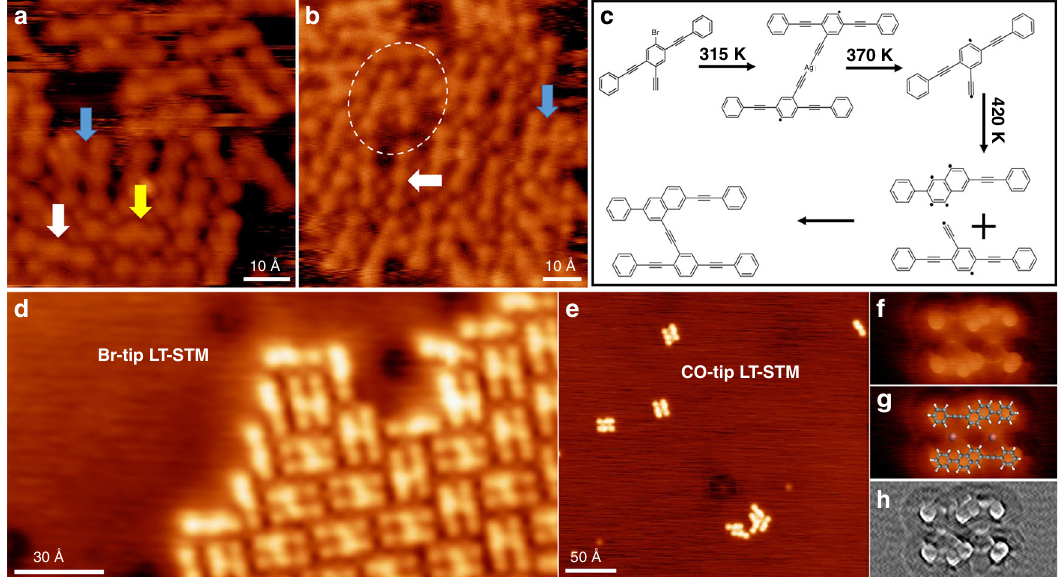
Fig. 4 Reaction process and its evidences. a , b STM images of the sample by annealing to 370 K. Various different intermediate and fi nal products are pointed by different colored arrows, except the white circled organometallic species. c The reaction process of the formation of H-type product 4 from molecule 6 on Ag(111). d Br-tip LT-STM image of the edge of H-type molecular island. e STM image of the sample upon fast annealing from 315 to 420 K. f , g CO-tip LT-STM image of the non-covalent dimer composed by monomers after cyclization, with and without superimposed molecular models. h Laplace and fast Fourier transform (FFT) fi ltered STM image of the non-covalent dimer in f . Tunneling parameters: a V = − 1.5 V, I = − 0.3 nA; b V = − 2.2 V, I = − 0.2 nA; d , e V = 0.6 V, I = 0.5 nA; f V = 0.3 V, I = 0.5 nA. Color code: C, gray; H, white; Br,